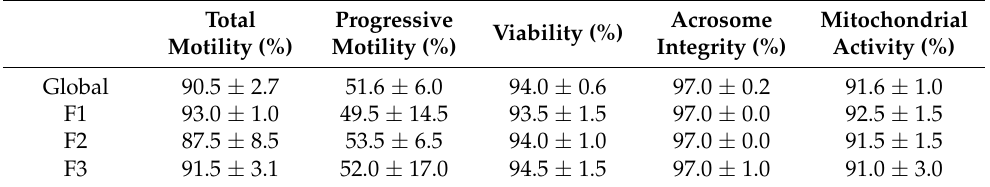
Figure 3. Demonstrative waveform pulse–Doppler representing variation in the blood flow of uterine arteries indices measured during estrus (D 0) and after AI (D1 and D5) using Doppler ultrasonography in three selected sows. Representative Doppler ultrasound images were obtained using the MyLab TM alpha (Esaote España S.A., Barcelona, Spain) color Doppler ultrasound machine. Table 3. Spermatozoa quality values from different seminal dose types used (F1, F2, and F3) and global values (including F1, F2, and F3). Data are represented as mean ± SEM (standard error of the mean).